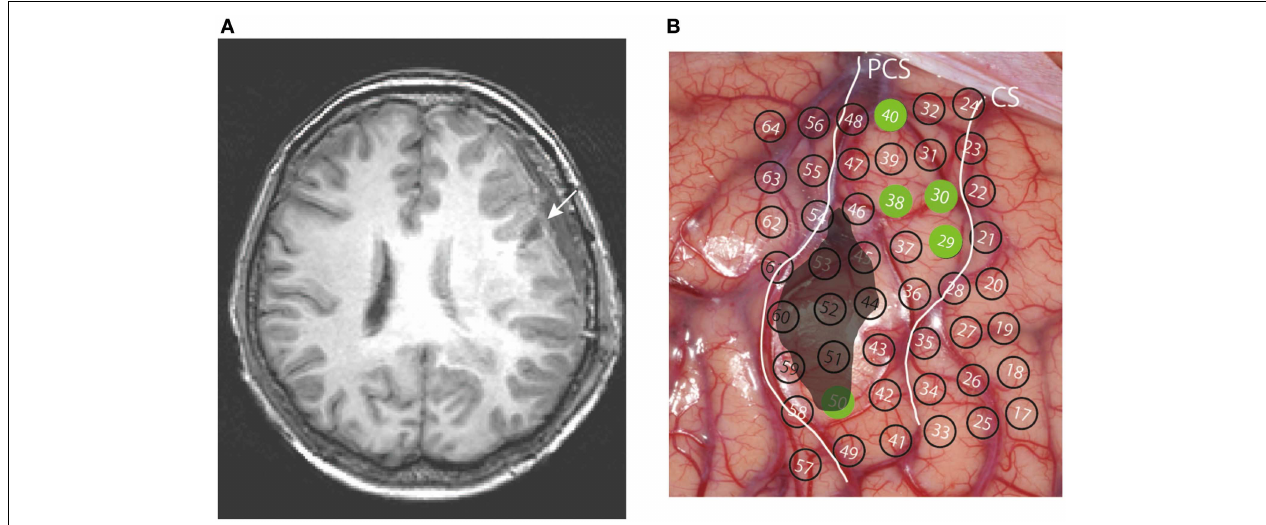
FIGURE 4 | (A) Post-operative axial MR image of the resected region (arrow) in a slice most similar to Figure 1B . (B) Resected area (black) superimposed on the cortical surface, with the positioning of the electrodes.